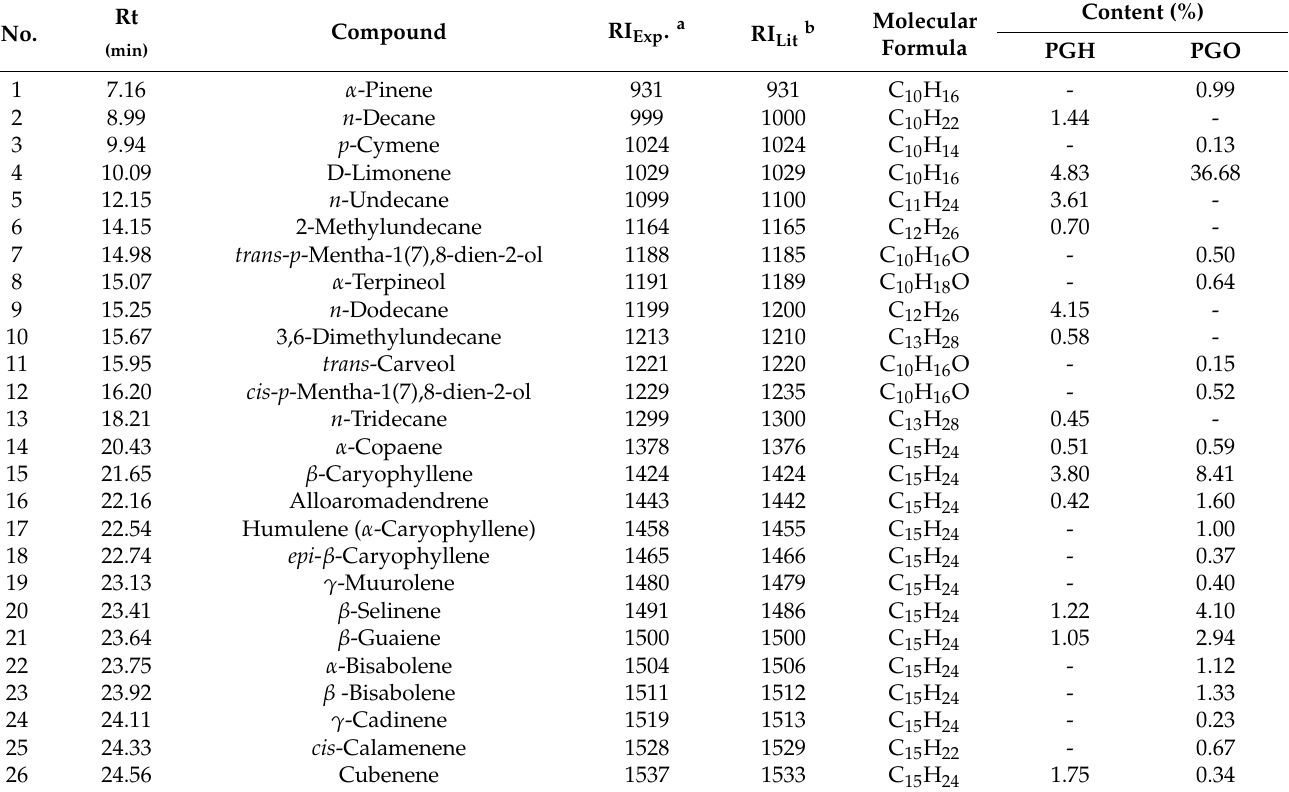
Table 1. Chemical composition (%) of the n -hexane extract (PGH) and essential oil (PGO) isolated from Psidium guajava leaves using GC/MS